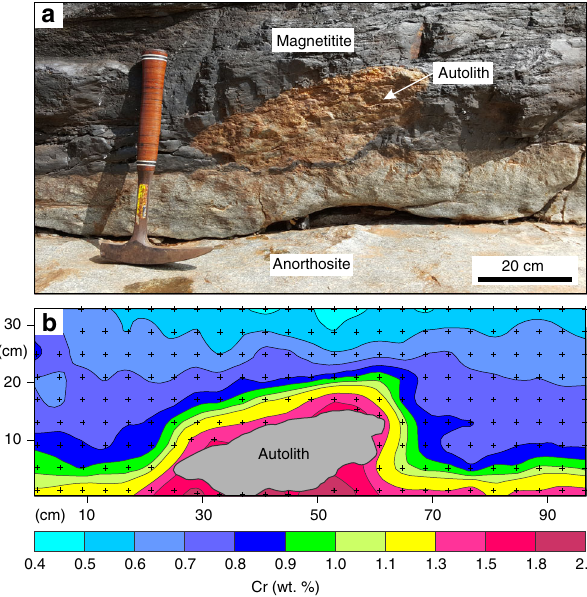
Fig. 4 Two-dimensional geochemical map of basal part of the Main Magnetite Layer that contains a sub-rounded anorthosite autolith. Field photograph of the section and the corresponding geochemical contour map are shown in ( a ) and ( b ), respectively. Black crosses indicate the positions of individual data points. Notice how the geochemical contours drape over the autolith, indicating in situ growth all along its outer surface. Several growth nodes appear directly underneath the autolith as well. The outcrop is located at Magnet Heights, Eastern Bushveld Complex.